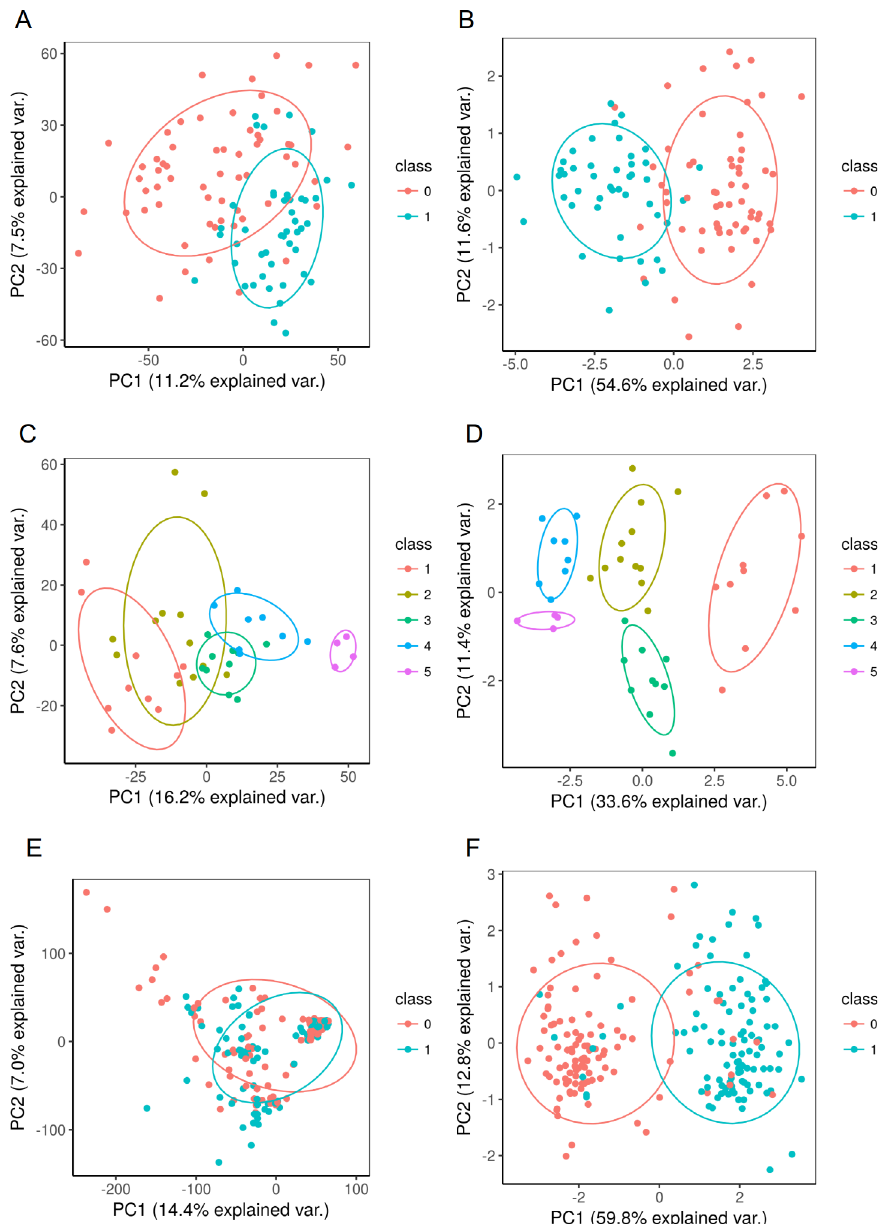
Fig 6. Visualization of the classification process using the first two principalcomponents(PC1 and PC2) from the originaldata before (A, C, E) and after (B, D, F), to apply the followingFS workflow: Univariatecorrelation (X2) with correlation matrix filter (CM) follow by Recursive Feature Elimination(RFE) wrappedwith random forest (RF). The figure shows the classes distributionfor Dataset 1 (A, B), Dataset3 (C, D) and Dataset 4 (E,